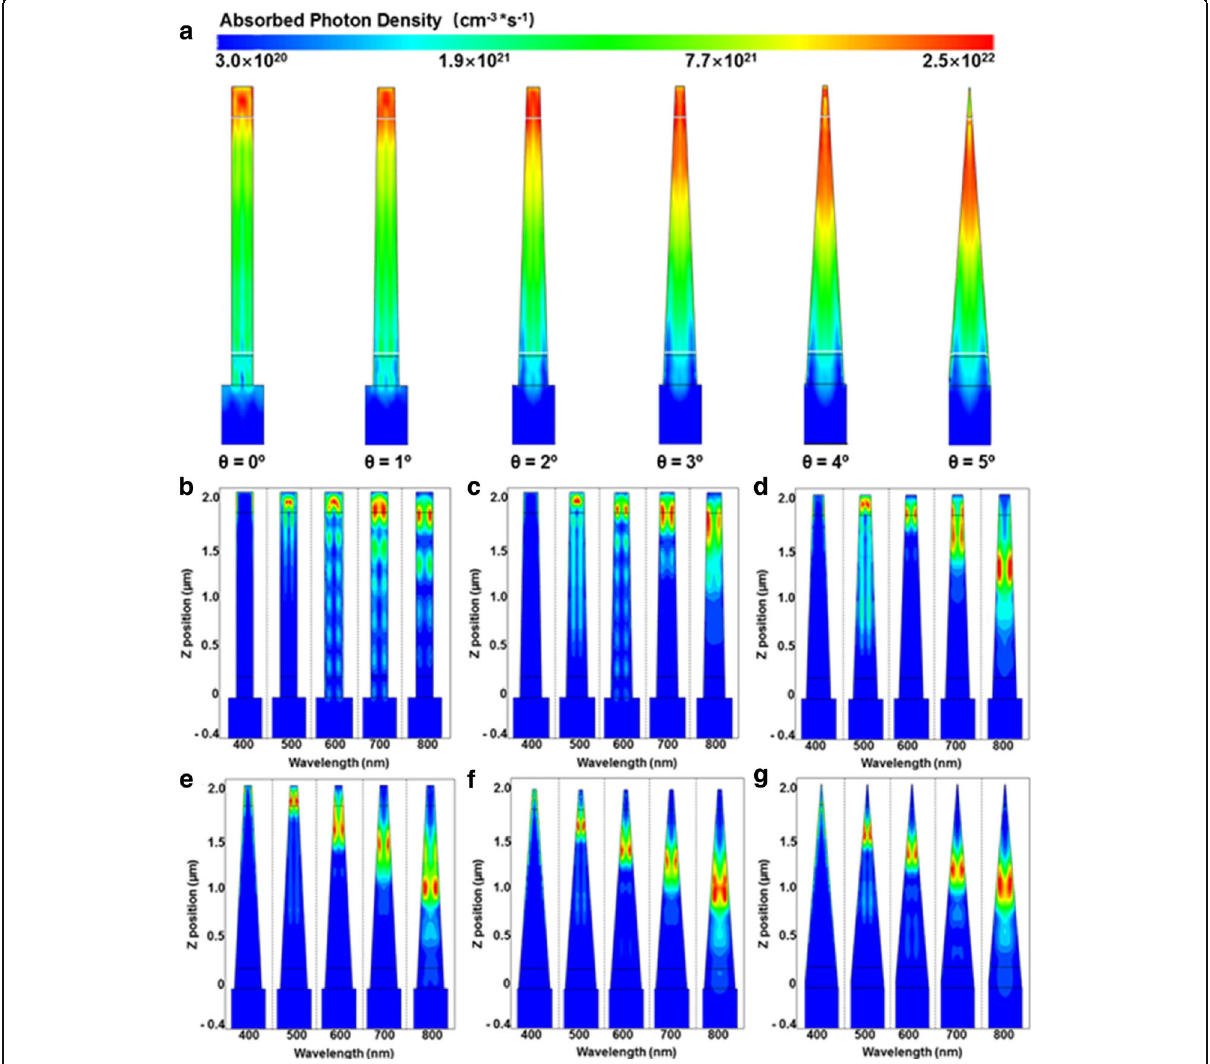
Fig. 3 a The total optical generation profiles of the axial pin nanocones. b – g Wavelength-dependent optical generation profiles of nanocone arrays at θ = 0~ 5°